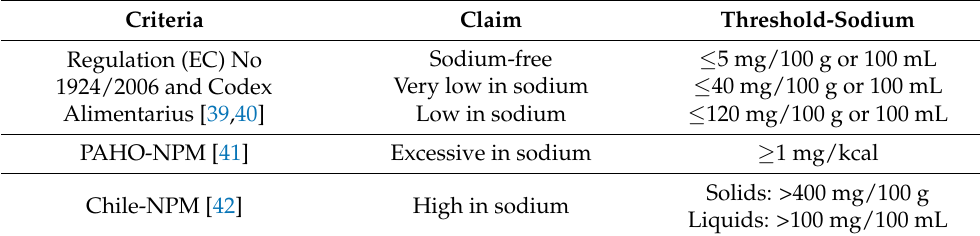
Table 1. Criteria used to classify foods according to their sodium content. Criteria Claim